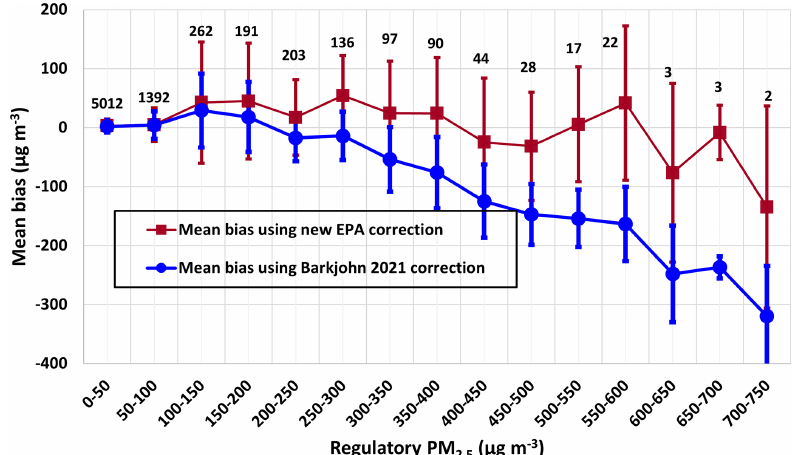
Figure 2. Comparison of mean bias (corrected PAS–regulatory data) using the hourly data for smoke and urban pollution events in Part I using the Barkjohn 2021 and new EPA correction schemes. Data are binned by regulatory PM 2 . 5 in 50µgm − 3 bins, as shown on the x axis. The values above the red points are the number of hourly data points in each bin, which is the same for both the Barkjohn 2021 and the new EPA-corrected values. The error bars show 1 standard deviation within that bin. Table 5. Mean regulatory (reg) PM 2 . 5 , PAS PM 2 . 5 (with the Barkjohn 2021 correction and with the proposed dust correction), ratio of PAS PM 1 / PM 10 raw concentrations (CF = 1), and ratio of PAS 0.3µm / 5µm counts by coarse aerosol fraction (CAF) bins. The CAF bins are centered on the indicated value. CAF bin N Regulatory PAS PM 2 . 5 with PAS PM 2 . 5 with Mean ratio Mean ratio of midpoint (h) PM 2 . 5 the Barkjohn 2021 the dust correction of